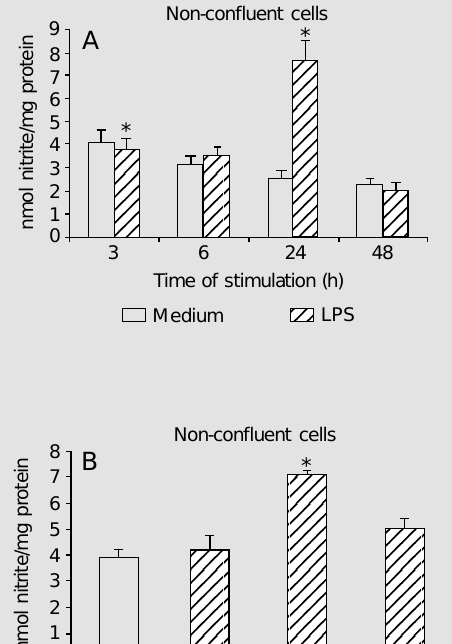
Figure 1. Lipopolysaccharide (LPS)-stimulated NO release by rabbit vascular smooth muscle cells (RVSMC). RVSMC were serum-starved for 24 h before incubation with LPS. A , Non- confluent, low-density RVSMC were exposed to LPS (10 ng/ml) or medium at the times indi- cated. *P<0.05 compared to medium at the same time (Stu- dent t -test). B , Non-confluent, low-density RVSMC were ex- posed to LPS at the indicated concentrations for 24 h. *P<0.05 compared to medium and other concentrations of LPS (Student t -test). C , Non-confluent, low- density RVSMC were exposed to aminoguanidine (AG, 400 µM) 30 min prior to 24-h stimulation with LPS (10 ng/ml). *P<0.05 compared to cells pretreated with AG and stimulated or not with LPS (Student t -test). D , Multilayered RVSMC were incu- bated for 24 h with LPS at two different concentrations (10 and 100 ng/ml). After incubation, NO production was estimated as ac- cumulated nitrite in cell culture supernatants. Results are re- ported as means ± SD of three independent experiments per- formed in